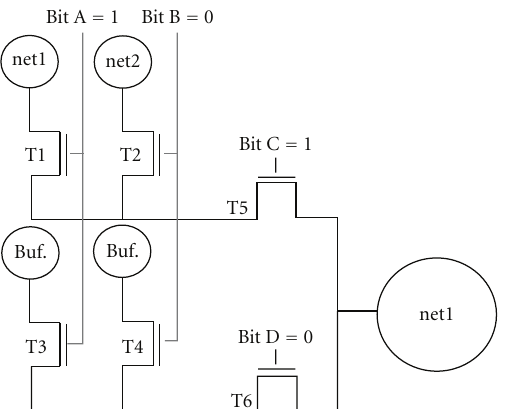
Figure 5: A simplified pip under normal operating conditions. No bits a ff ected by SEUs.